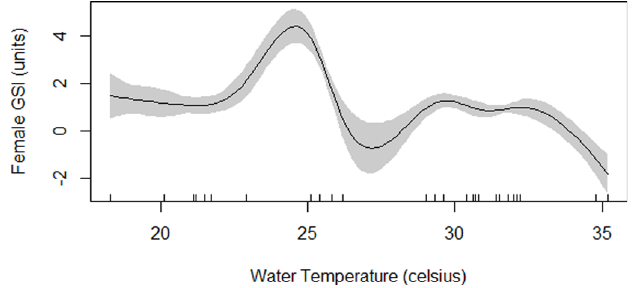
Fig. 3. GAM models showing optimum water temperature for breeding of J. coitor